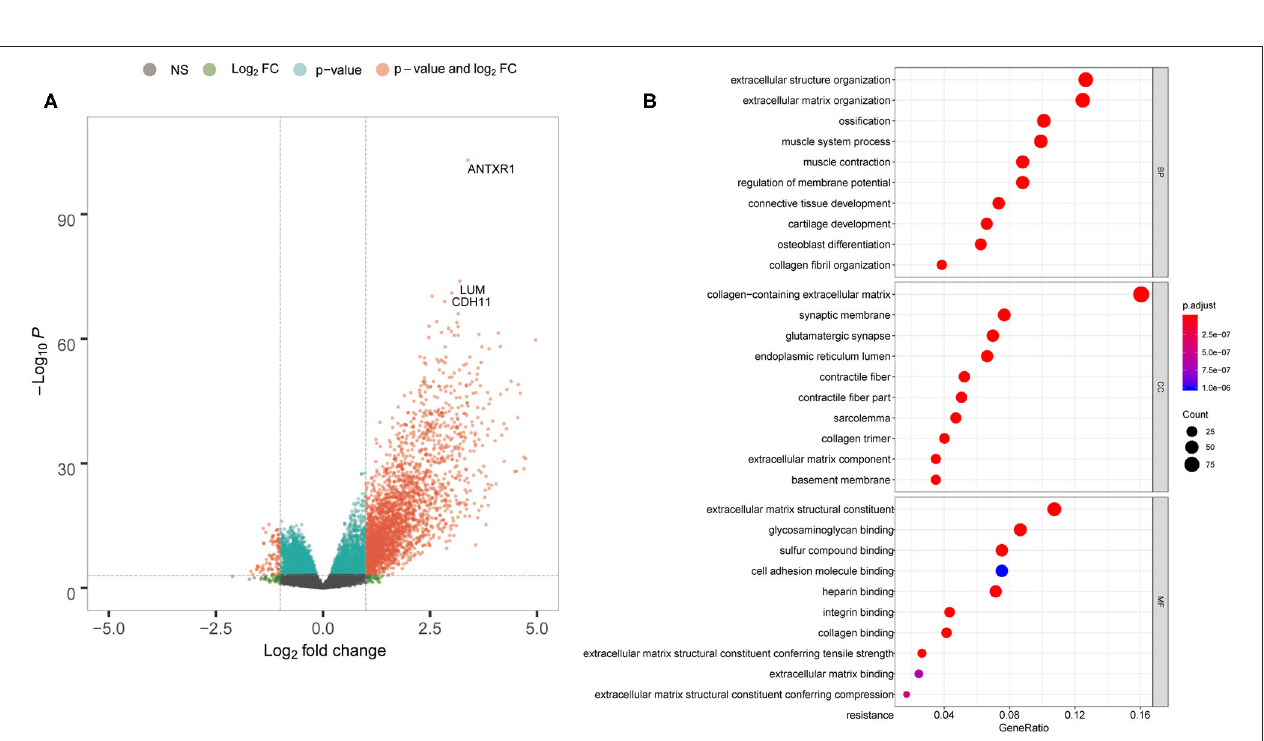
FIGURE 3 | ANTXR1 involved in definite gene ontology (GO) terms in gastric cancer. (A) Volcano plot of the differentially expressed genes. (B) Results of BF (biological function), CC (cellular component), and MF (molecular function) terms analyzed.